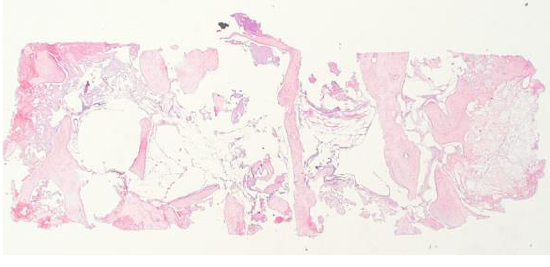
Figure 15. 3× magnification.